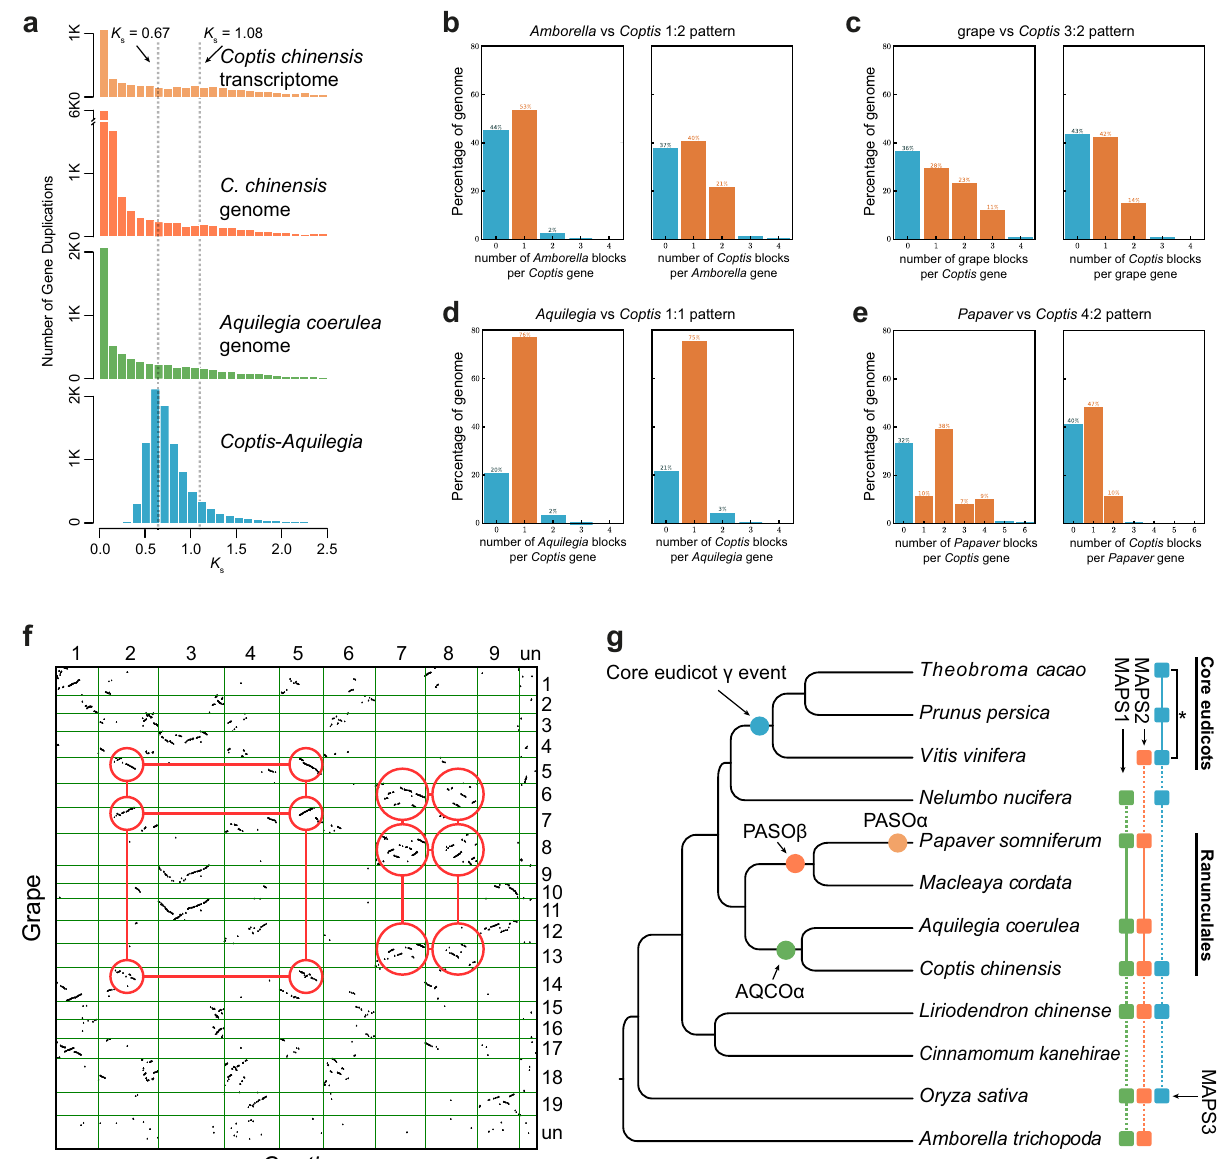
grape vs Coptis 3:2 pattern